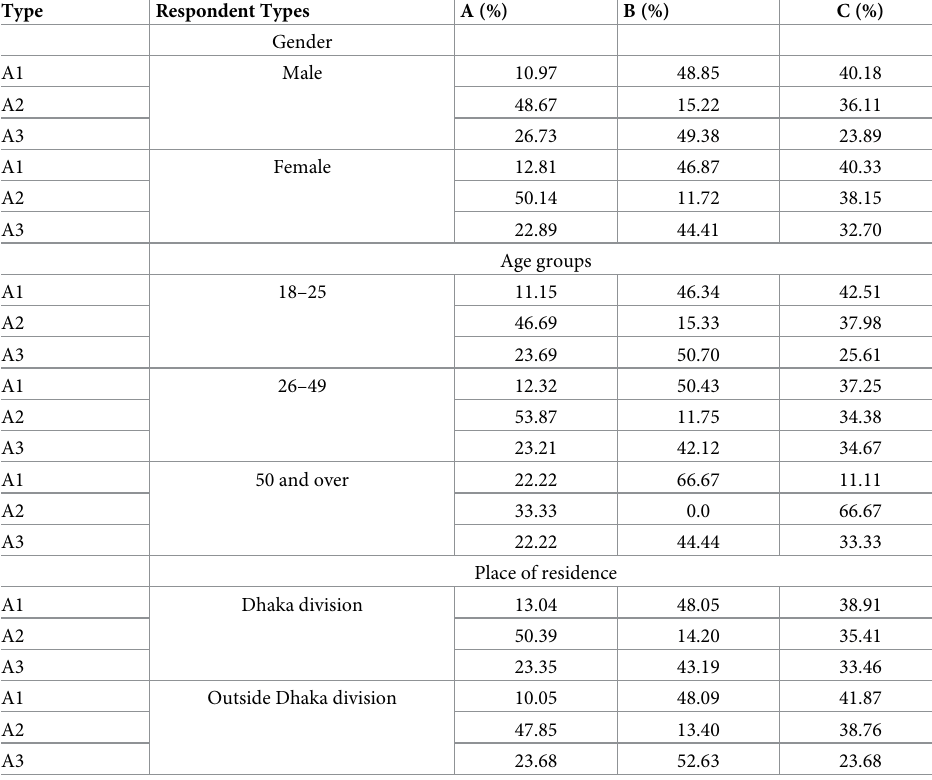
Table 4. Distribution of attitude related characteristics among the participants.